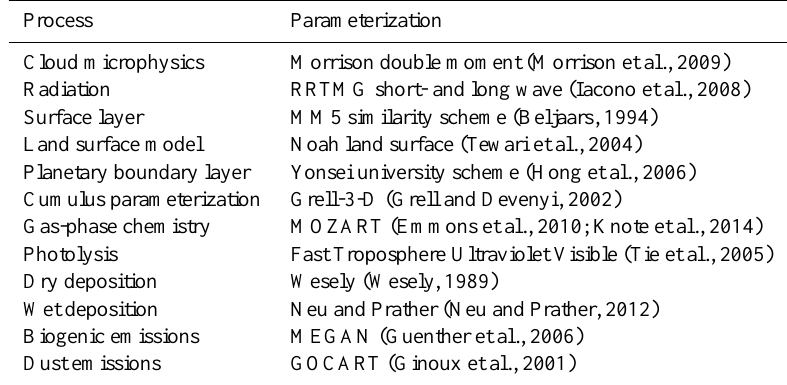
Table 2. Parameterization used for selected atmospheric processes in